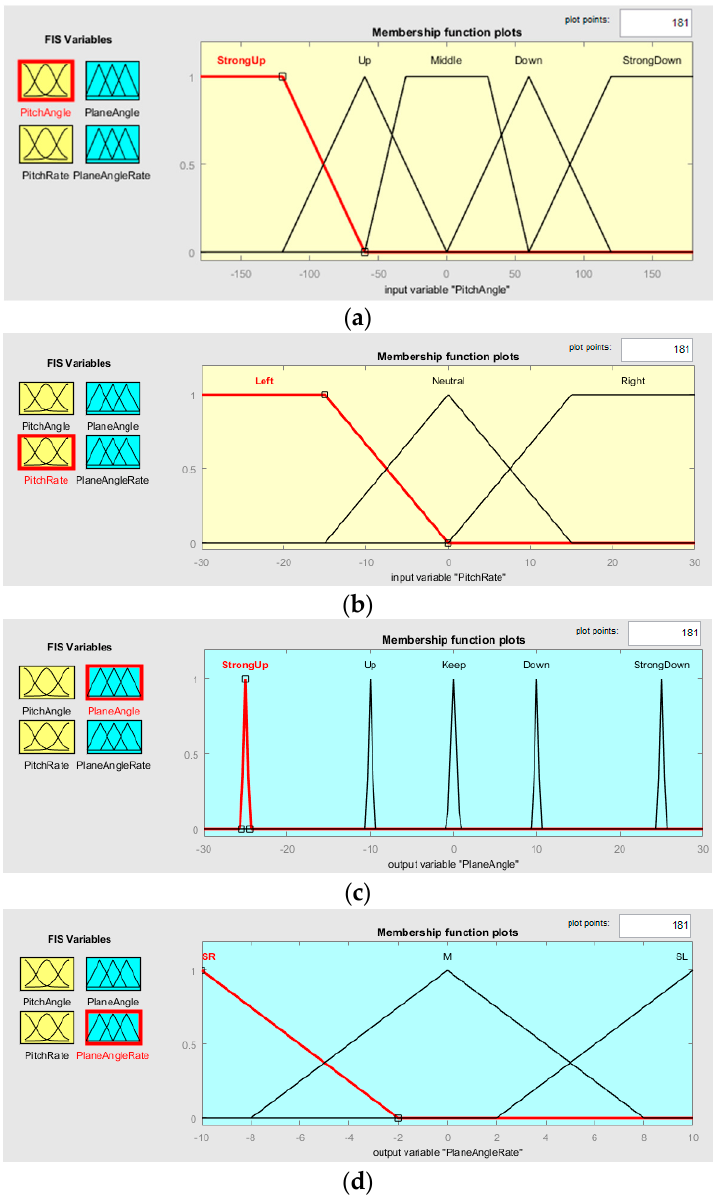
Figure 5. ( a ) Input variable 1—membership of the pitch angle; ( b ) input variable 2—membership of the pitch rate; ( c ) output variable 1—membership of the horizontal plane angle; and ( d ) output variable 2—membership of the horizontal plane angle rate.